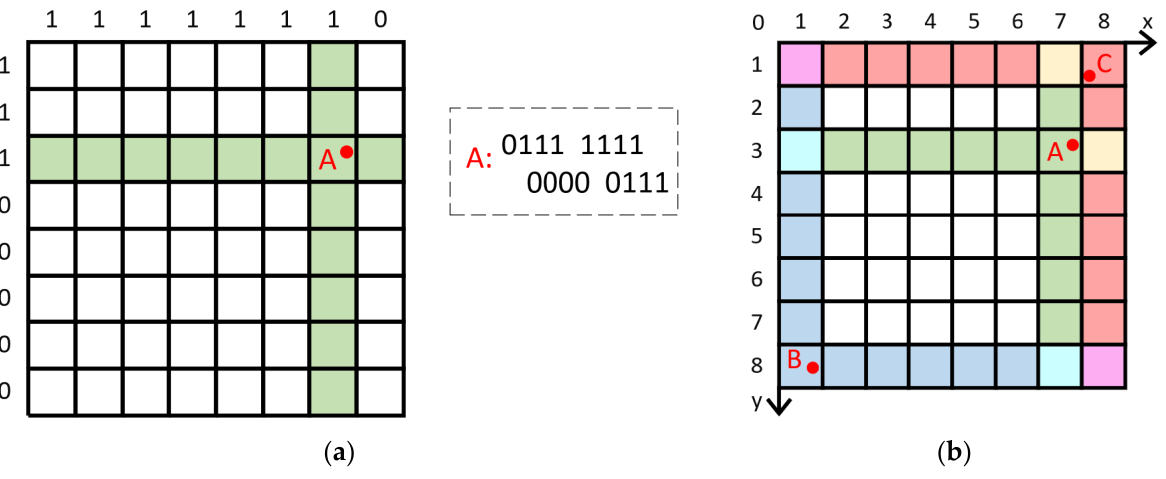
Figure 5. Coordinate description illustration. ( a ) Example of coordinate descriptor calculation. ( b ) Influence of coordinate descriptor on matching.